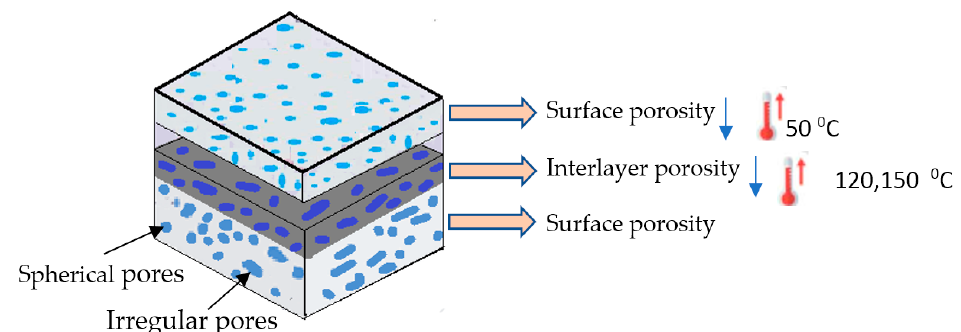
Figure 13. Effect of heat treatment on the surfaces of different samples, ( a ) At low temperature (50 °C), ( b )At high tem- peratures (120, 150 °C).